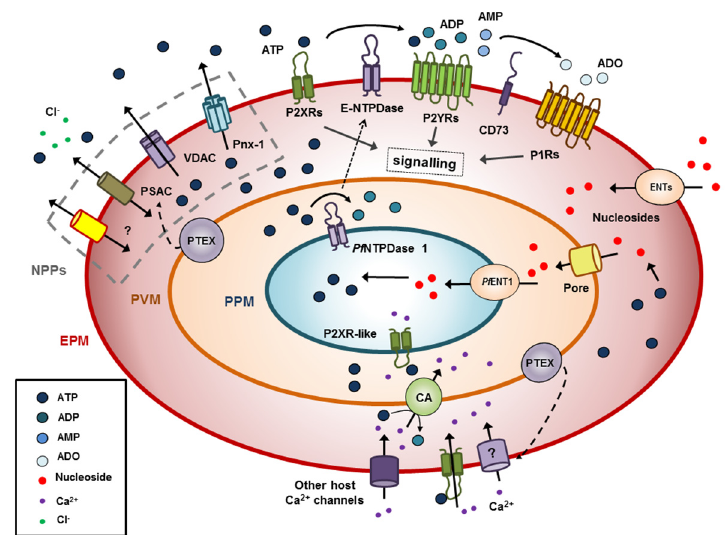
Figure 1. Extracellular ATP (ATPe) dynamics of Plasmodium falciparum infected erythrocytes. The parasite induces a general increase of solute permeability at the host cell membrane (EPM; erythrocyte plasma membrane), via new permeability pathways (NPPs), which includes an increase of ATP efflux mediated by several proteins like pannexin 1 (Pnx-1), anionic channels such as voltage-dependent anion channel (VDAC) coupled to partner proteins, generic solute pores as